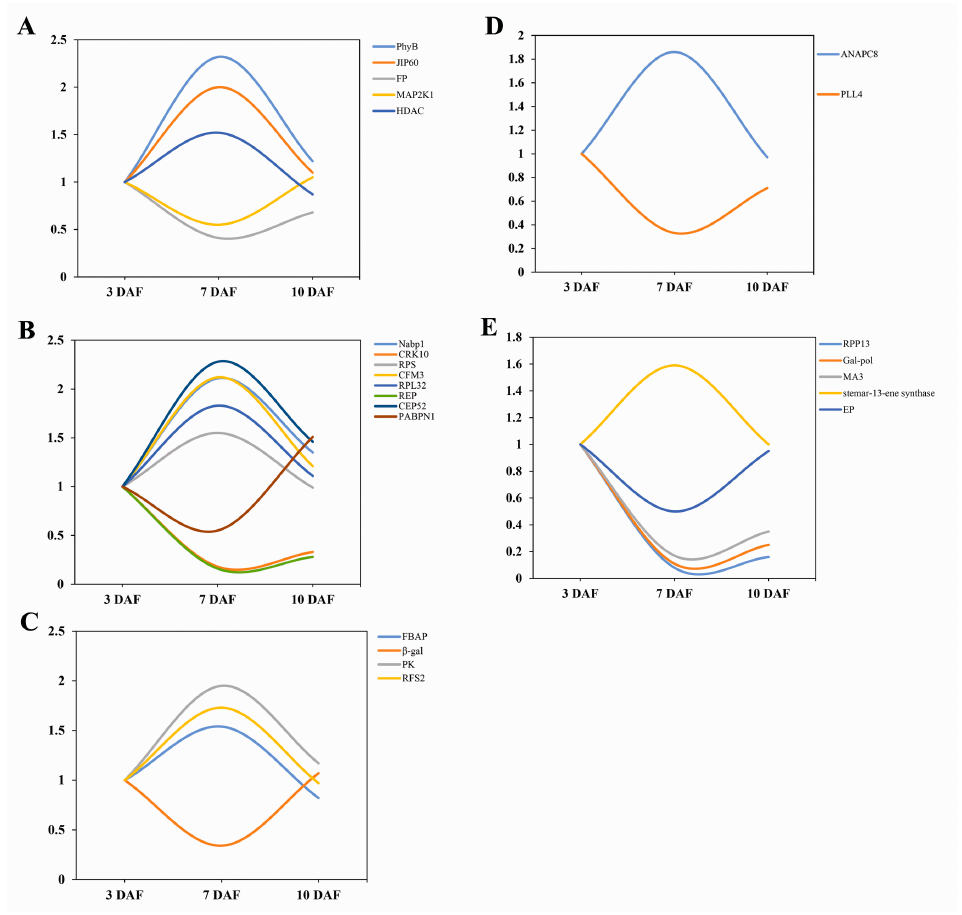
Figure 6. The expression of different functional proteins in leaves at different developmental stages: ( A ) signal regulated proteins and plant hormone proteins; ( B ) gene expression regulatory proteins; ( C ) carbohydrate metabolism-related proteins; ( D ) development-associated proteins; and ( E ) other proteins (the X axis represents the time point of kernel development, while the Y axis represents the relative expression level of proteins on 3 DAF).